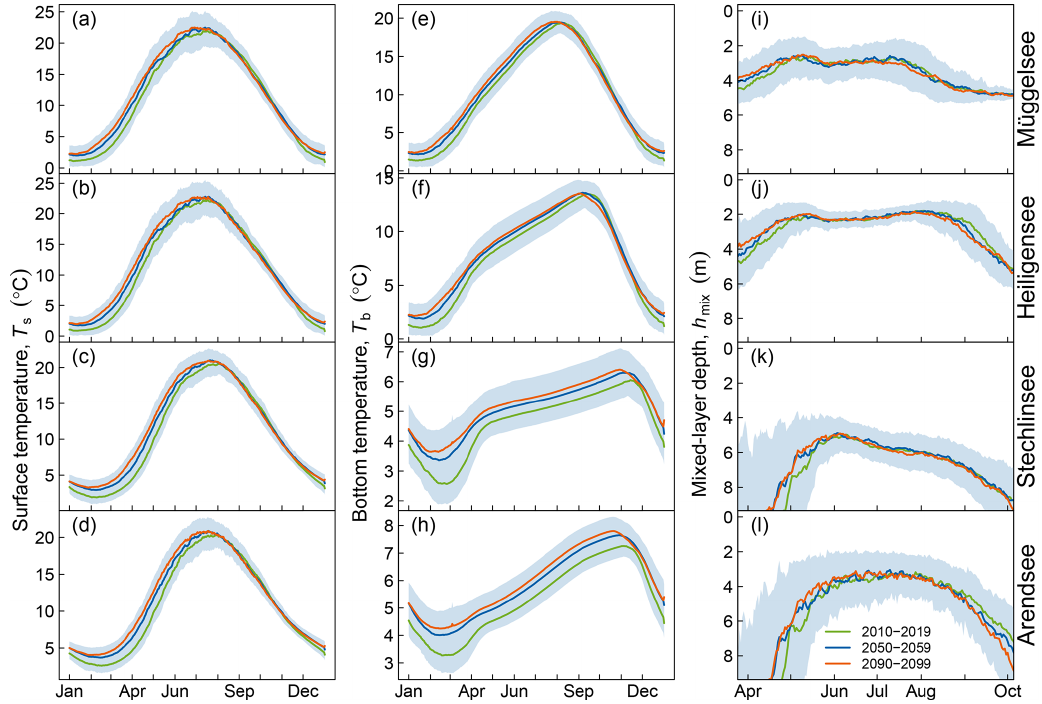
Figure 8. Modelled seasonal cycle of surface (a–d) and bottom temperature (e–h) and mixed-layer depth (i–l) in Müggelsee (a, e, i) , Heiligensee (b, f, j) , Stechlinsee (c, g, k) , and Arendsee (d, h, l) . Lines indicate decadal means and shading denotes 1 standard deviation each side of the mean.